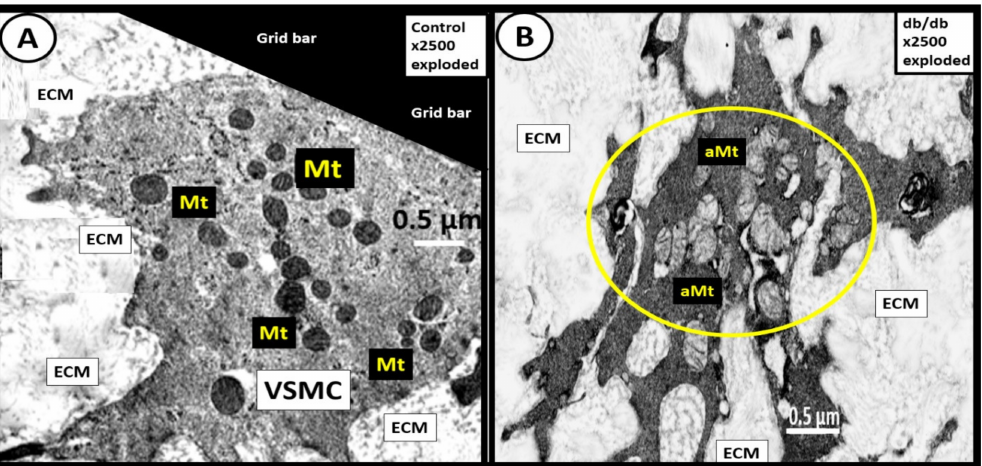
Figure 22. Aberrant mitochondria (aMt) in the obese, insulin resistant, diabetic db/db model vascular smooth muscle cell(s) (VSMCs) in the descending aorta. Panel A demonstrates the markedly electron- dense healthy mitochondria (Mt) in the cytoplasm of a non-proliferative VSMC. Panel B depicts a cluster of hyperlucent aberrant Mt (aMt) (encircled with yellow line) in the cytoplasm of a proliferative VSMC with loss of the electron-dense Mt matrix and loss of crista as compared to the control C57BLKS/J models in panel A . Original Magnification × 2500; intact scale bar = 0.5 µ m. These images are exploded in a like manner with the scale bars intact to emphasize the normal control electron-dense Mt in panel A and the aMt in the db/db models in panel B . The original images for this figure are from the experiment with permission [69]. ECM = extracellular matrix